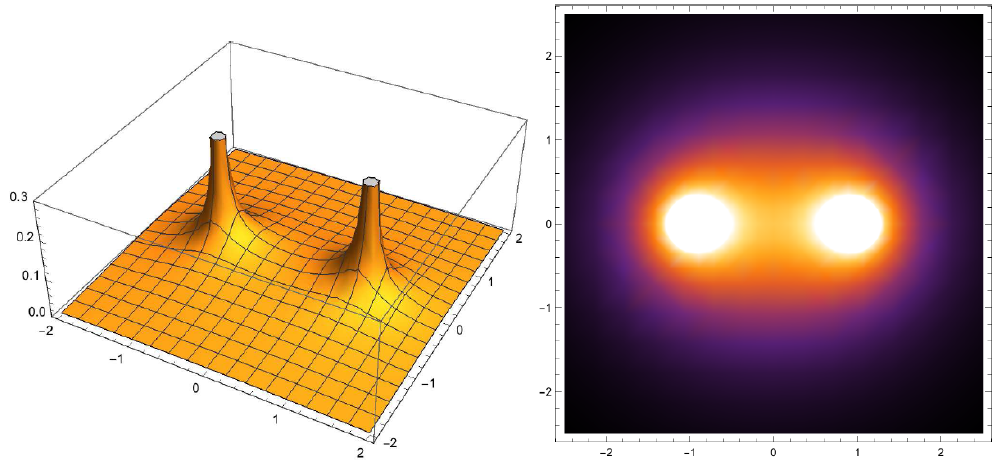
Tr[ F mn ~ F mn ] = @ 2 v 2 for the monopole in the 0 i 4